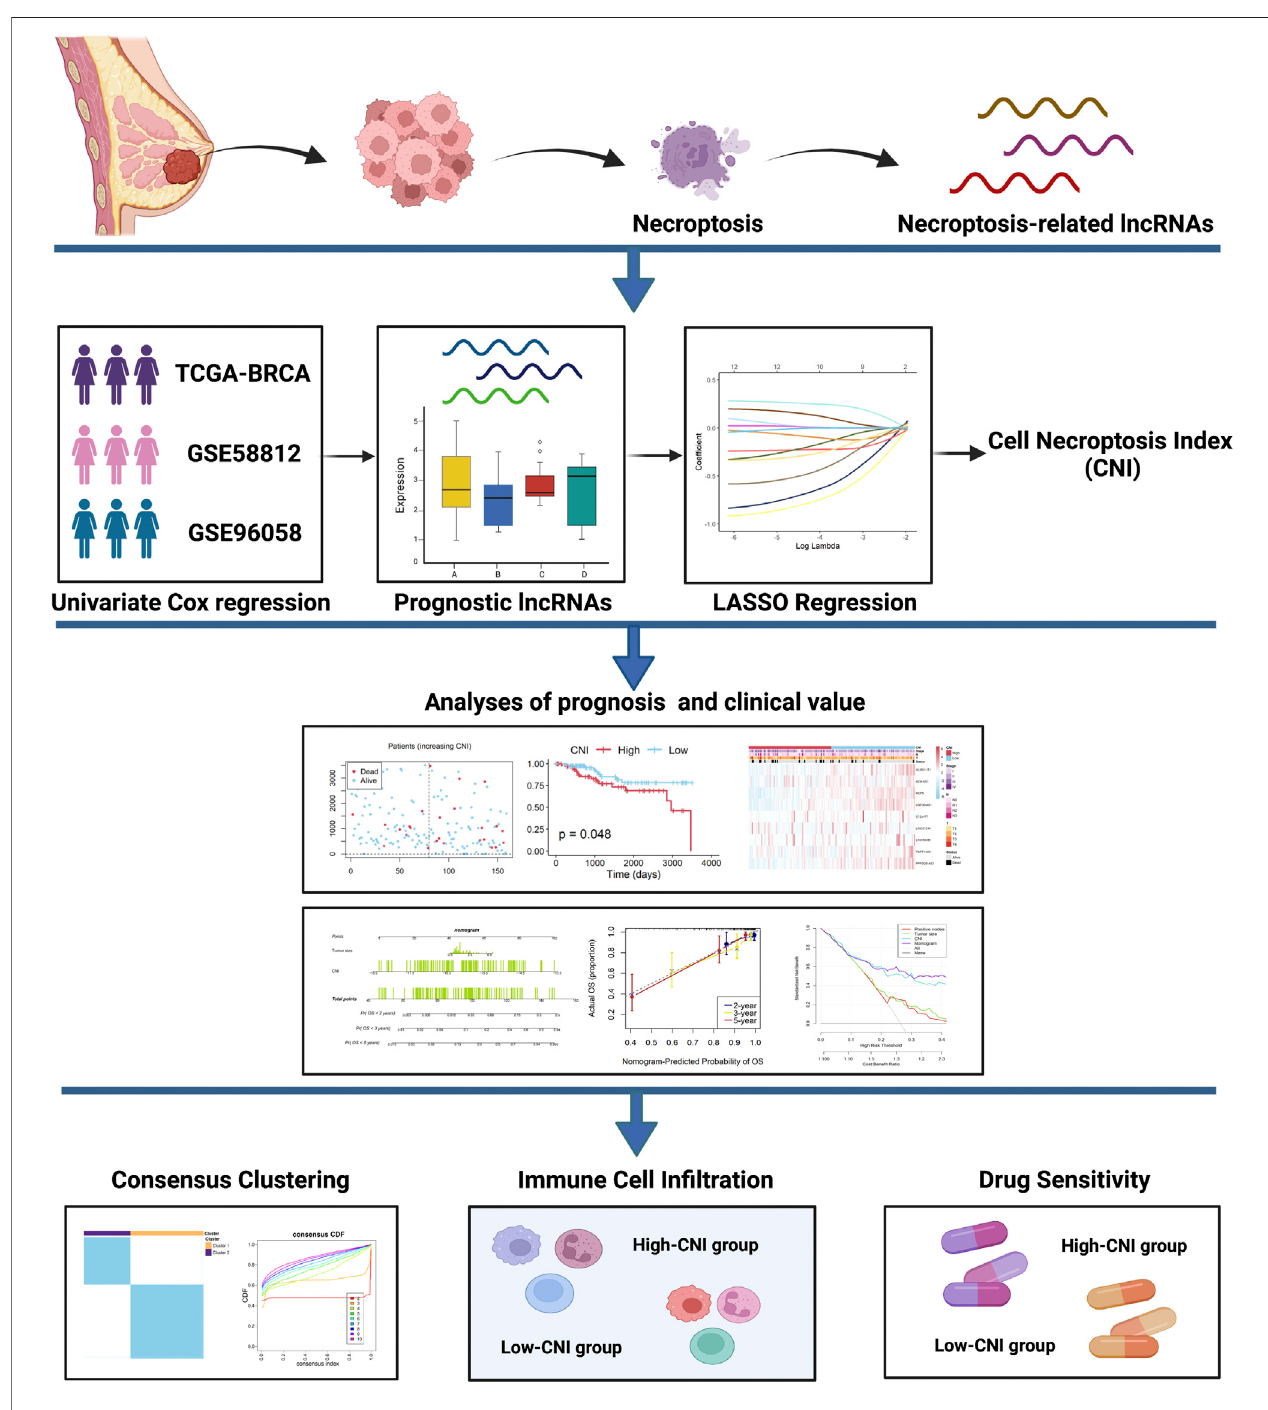
FIGURE 1 | The work fl ow of the present